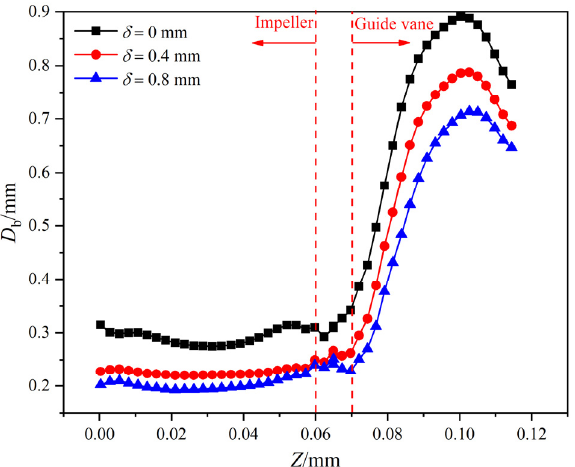
Figure 12. Variation in average bubble diameter.